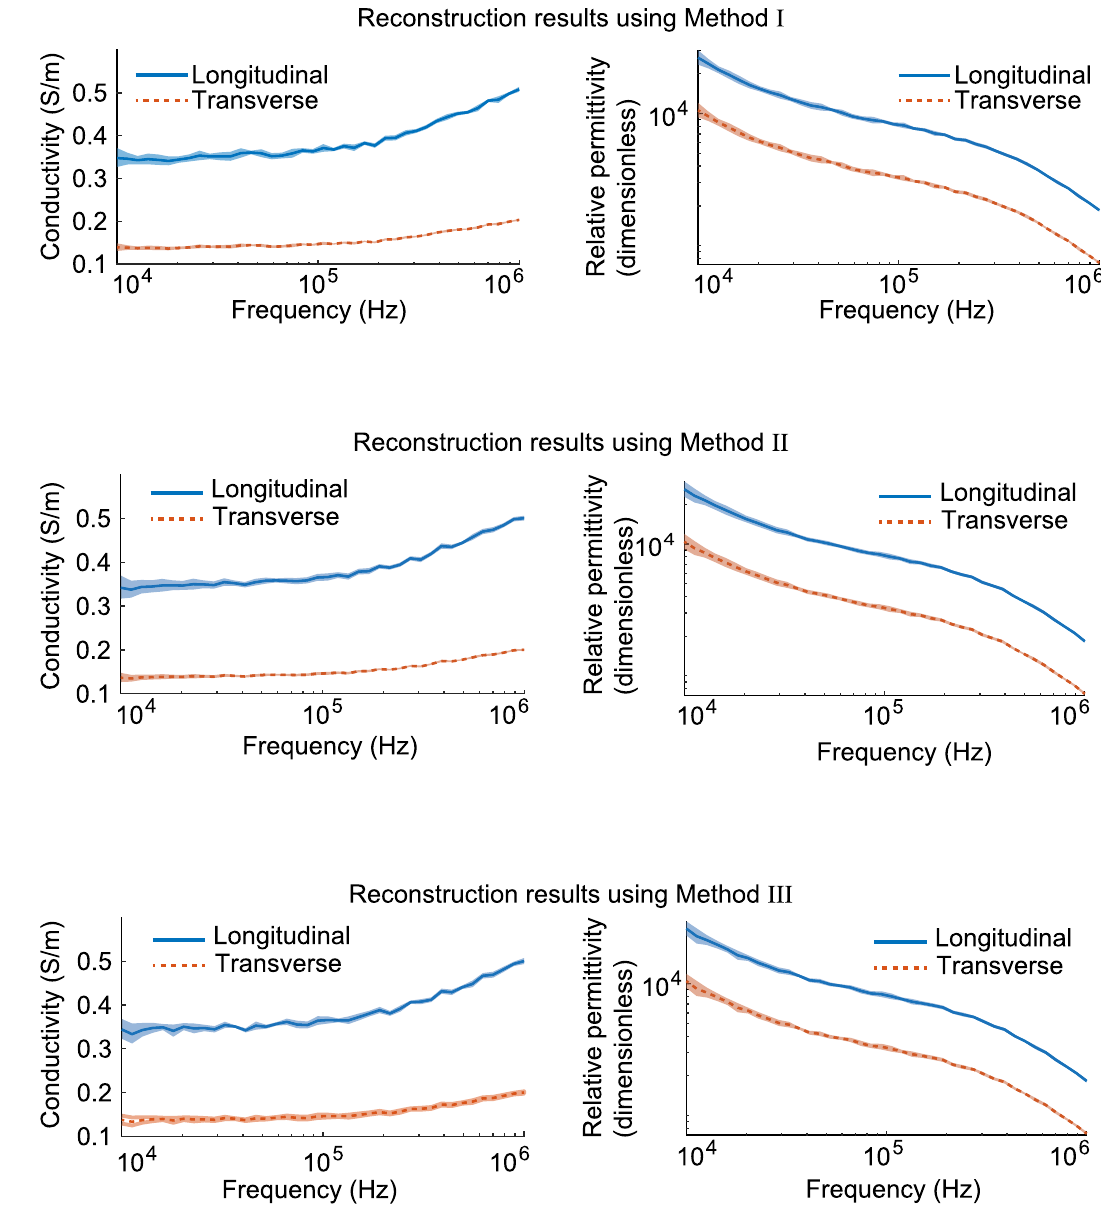
Figure 9. Estimated anisotropic permittivity (i.e., conductivity and relative permittivity) using method I, II, and III. The solid lines represent the true values, whereas the shaded area represent based on the estimated